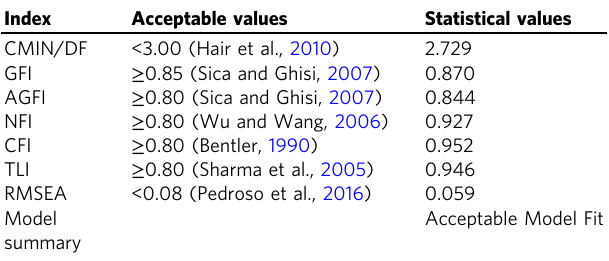
Table 5 Model Fit Criteria and values for the current